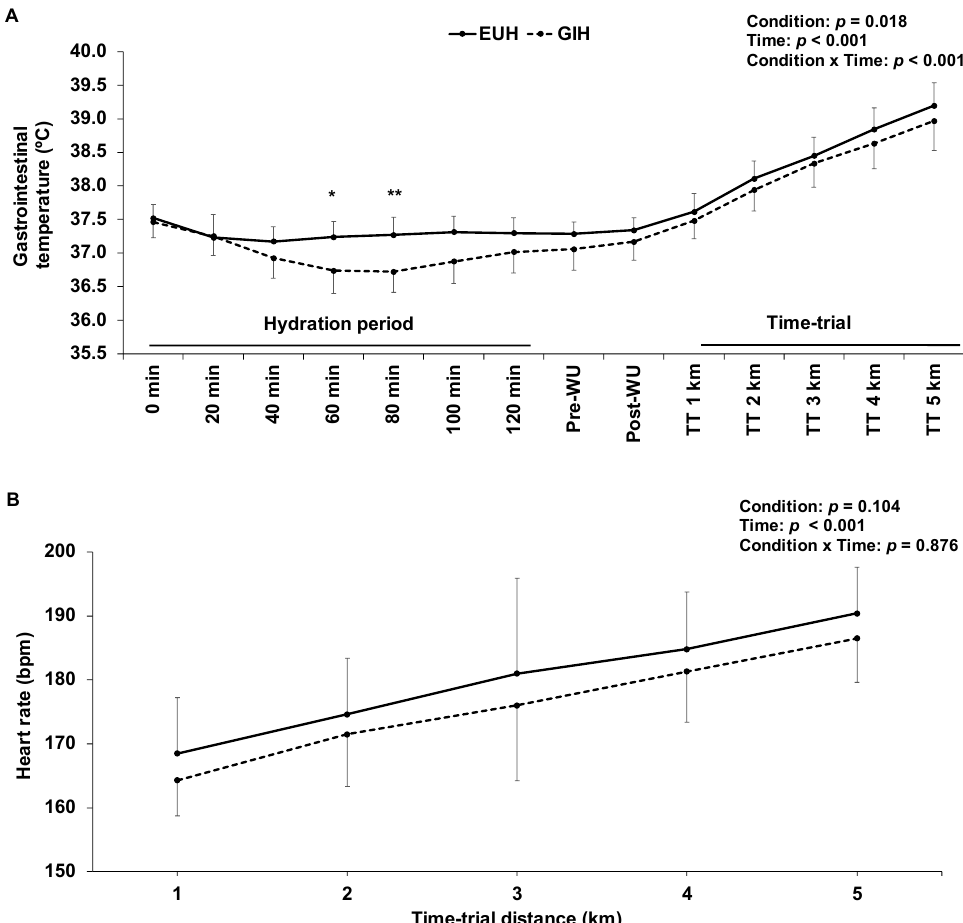
Figure 4. Effect of EUH and GIH on gastrointestinal temperature ( A ) over time during the hydration periods and time-trials and heart rate ( B ) during the time-trials only. * p < 0.05; ** p < 0.01 compared with EUH. EUH = euhydrated; GIH = glycerol-induced hyperhydration; TT = time-trial; WU = warmup.